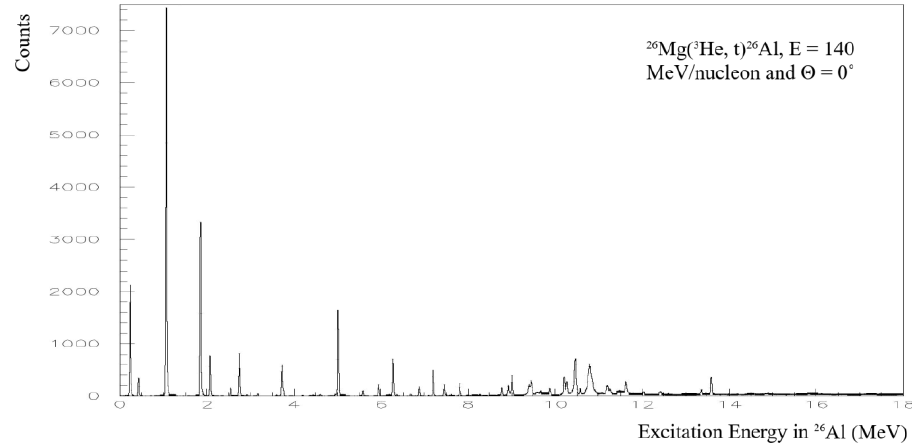
Fig. 2 The full count and full range spectrum of the 26 Mg( 3 He, t) 26 Al